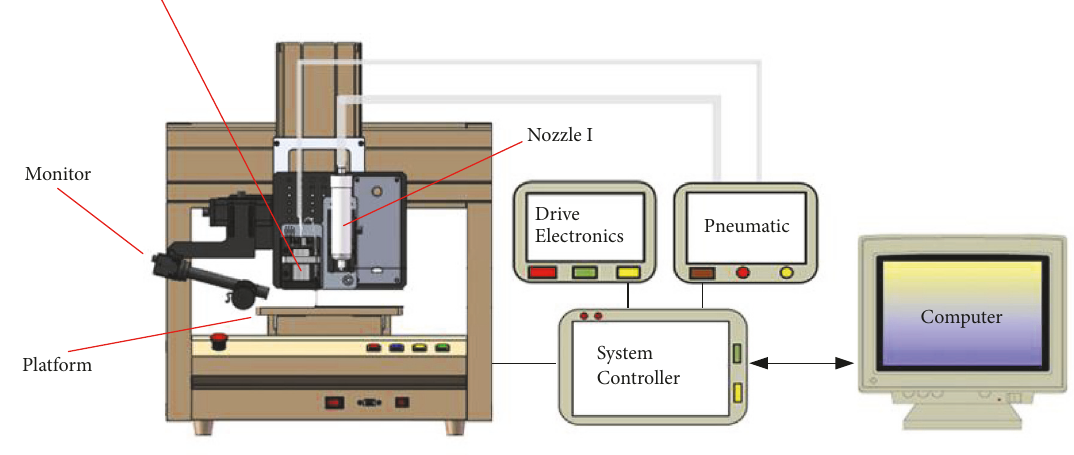
Figure 1: Schematic of dual-nozzle hybrid printing